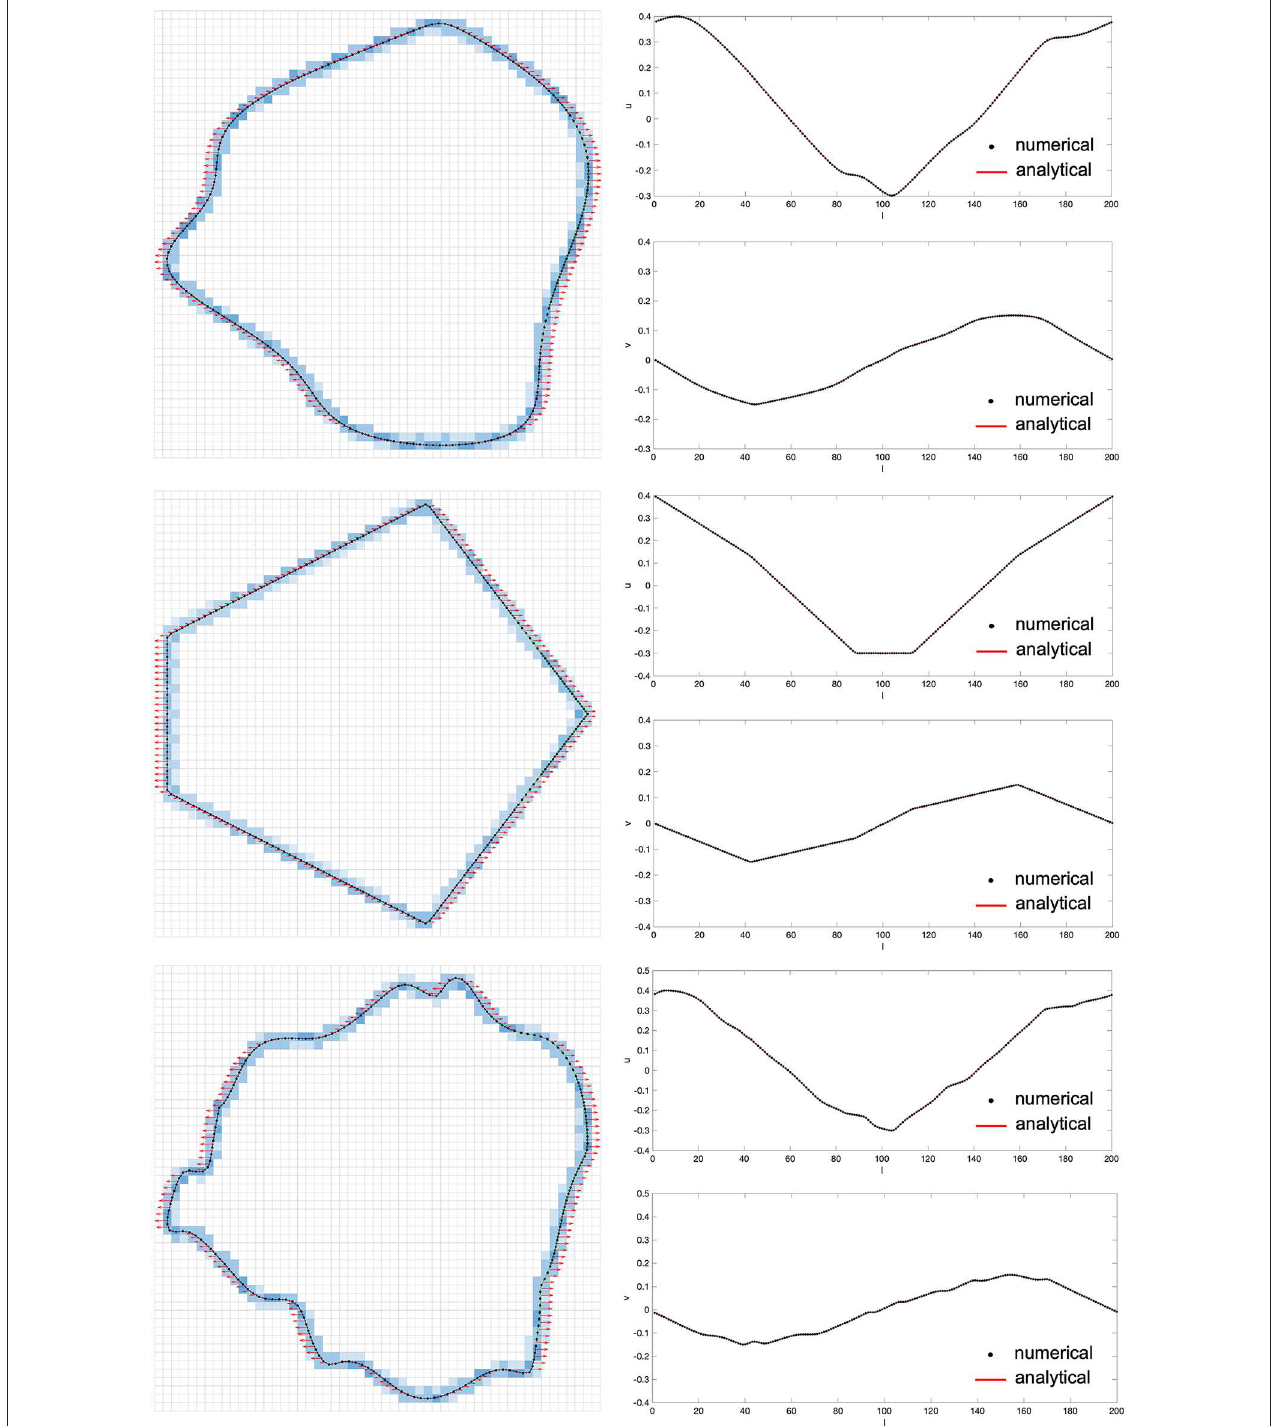
FIGURE 4 | Results for the boundary displacements of three different cutouts from a rectangular body (see left graph in Figure 1 ) with a uniformly distributed load σ A = 1, σ B = 0, and σ C = 0. For the elastic parameters it was chosen ν = 0.3 and µ = 1. The given stress distribution on the boundary is displayed with red arrows (left images), and the numerical results for the displacements on the boundary are shown in the diagrams on the right with black dots plotted over the analytical solution. l denotes the number of the equally spaced boundary